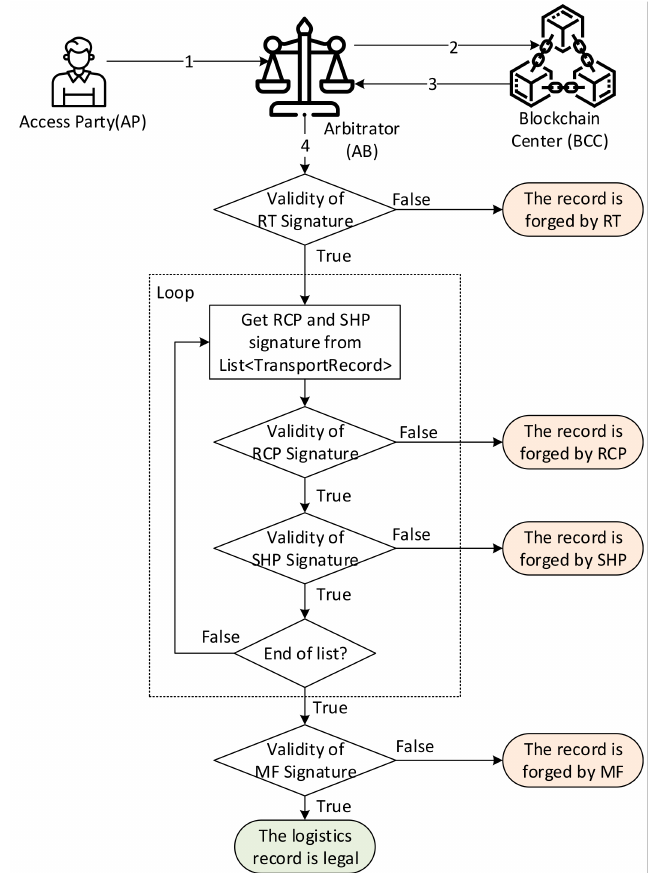
Figure 14. The validation flow in the arbitration